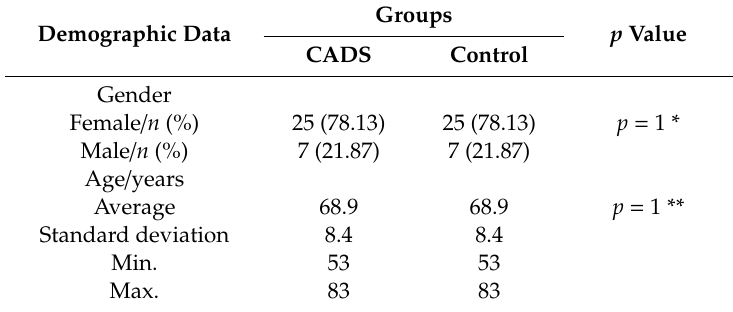
Table 1. Demographic data of subjects in Candida -associated denture stomatitis and control groups.